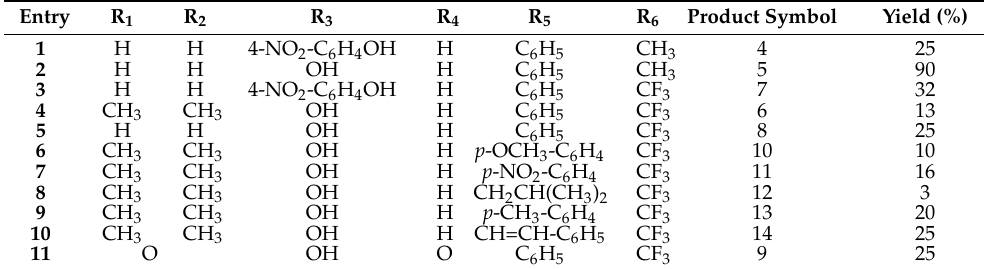
Table 1. Peptidomimetics synthesized by Scheme 2.